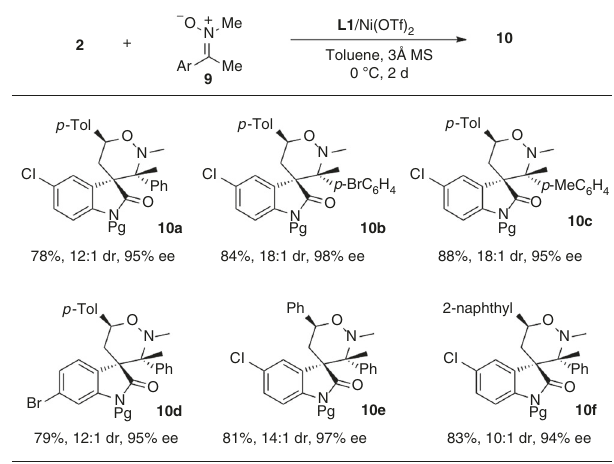
Fig. 3 Cycloaddition of spirocyclopropyl oxindoles using ketonitrones. Construction of adjacent quaternary and tetrasubstituted carbon